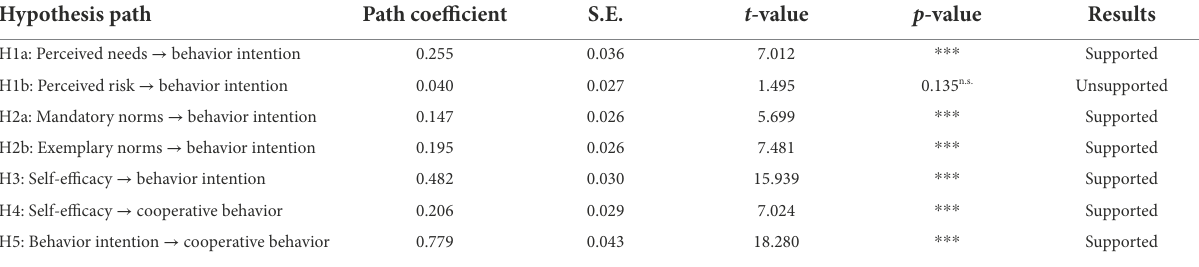
TABLE 6 Hypotheses test.